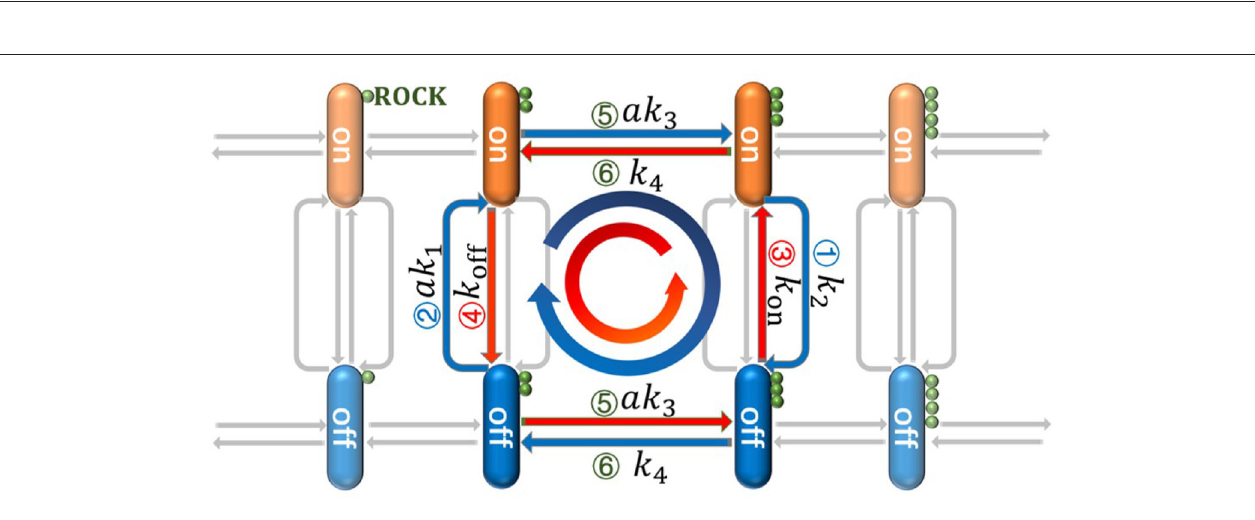
FIGURE 2 | The detailed cascades in the double-deck loop (DDL) which is a simplified model based on the biochemical reaction networks in Figure 1 . The orange stick is the gene in the “on” state and the blue one is the gene in the “off” state; ROCK is represented as the small green ball; Arrow 1 corresponds to the Rho/ROCK pathway in Figure 1 and Arrow 2 corresponds to the Rho/SRF pathway. The negative regulation from ROCK can push down the state of gene from the “on” state to the “off” state along Arrow 1 with rate k 2 . The positive regulation from RhoA* can also push up the state of gene along Arrow 2 with rate ak 1 . The Arrow 3 and 4 represent the basic switching of gene’s state with rates k on and k off respectively. The synthesis and degradation of ROCK will drive the system move along the horizontal directions (i.e., Arrow 5 and 6) with rates ak 3 and k 4 , respectively. Since two parallel loops (i.e., the blue and red loops) can be found in our model, it is so called